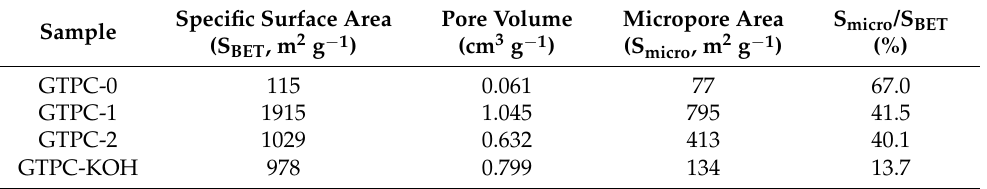
Table 1. Specificsurfaceareas, porevolume, microporeareas,